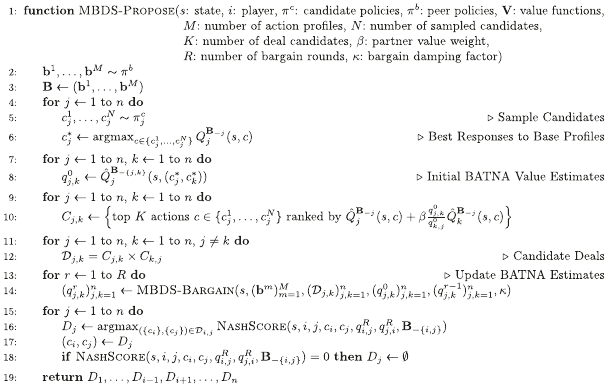
Algorithm 5 Mutually Bene fi cial Deal Sampling